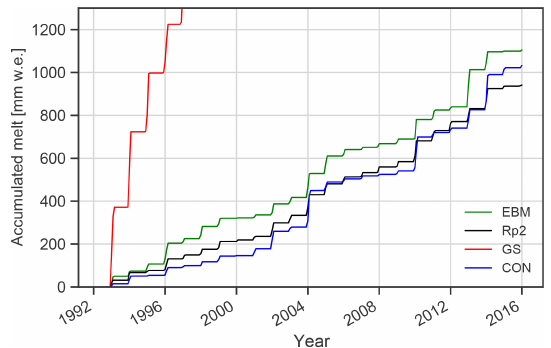
Figure 13. Domain-integrated yearly-averaged melt for the AIS in Gtyr − 1 measured by QSCAT and modeled in Rp2, GS and CON.